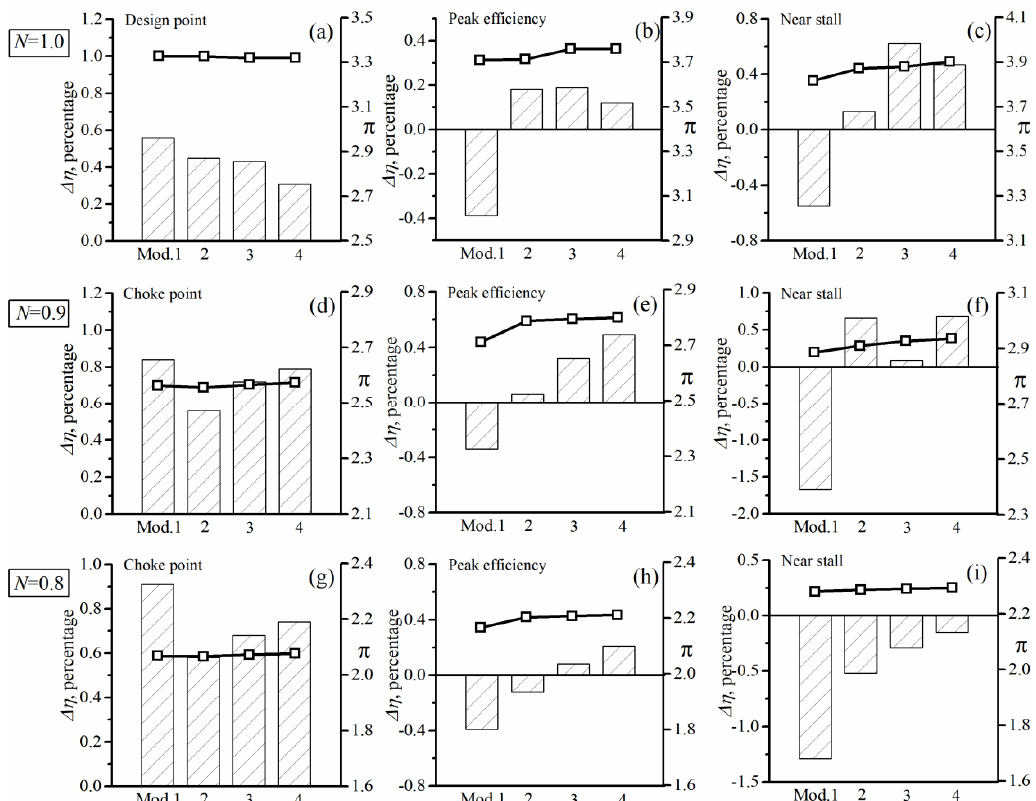
Figure 10. The influence of R2 and S1 modifications in single flow-path mode (SFM) ( a – c ) for N C = 1.0, ( d – f ) for N C = 0.9 and ( g – i ) for N C = 0.8.